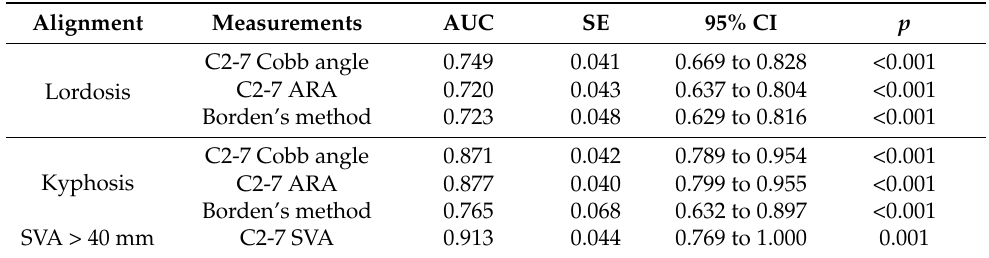
Figure 5. ROC curves for lordosis, kyphosis, and C2-7 SVA > 40 mm. ROC: receiver operating curve, Cobb: C2-7 Cobb angle, ARA: C2-7 absolute rotational angle, Borden: Borden’s method, SVA: C2-7 sagittal vertical axis. Table 2. Area under the curve of the four measurements.